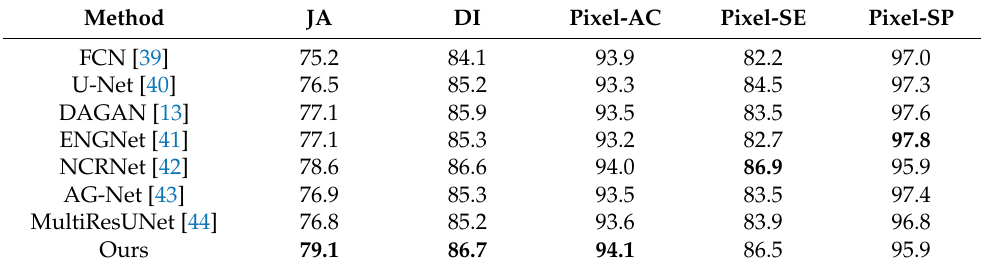
Figure 5. Segmentation results generated by the CL-DCNN model at each stage: ( a ) dermoscopy images, ( b ) segmentation results generated by teacher-SN, ( c ) CAMs generated by disease-CN, ( d ) segmentation results generated by student-SN, and ( e ) ground truth. Table 3. Segmentation performance of the CL-DCNN model and other skin lesion segmentation methods on the ISIC 2017 testing set. The highest results are shown in bold font for easy observation and